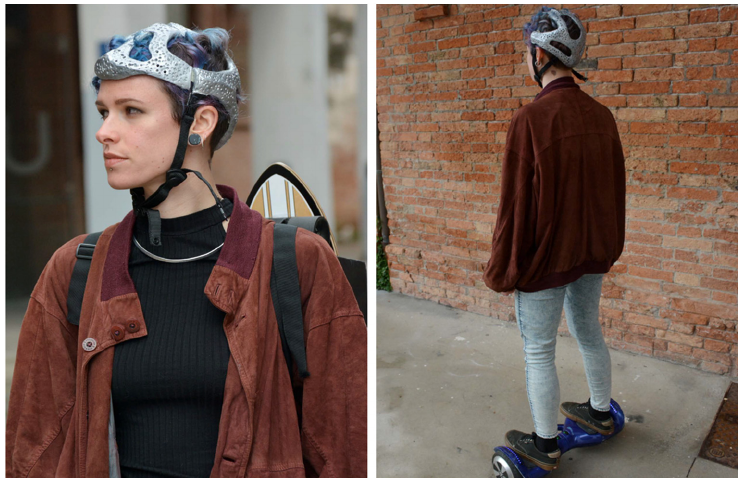
Figure 7. Pachycephalosaurus-inspired helmet. Design: Monica Bacelin. Research team: Carla Langella, Maddalena Mometti, Valentina Perricone,